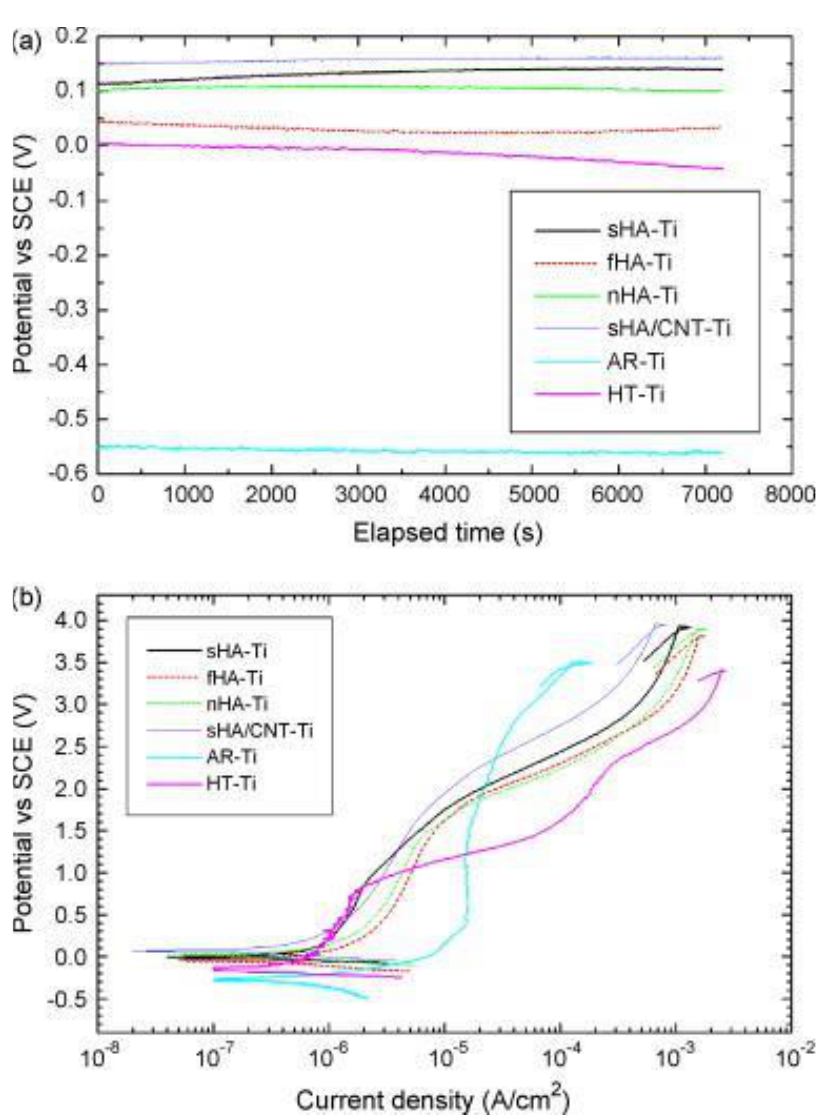
Figure 3. The enhanced corrosion resistance of Ti implants modified with hydroxyapatite (HA) nanoparticles (NPs). ( a ) The open circuit potential (OCP) and ( b ) potentiodynamic polarization curves of non-modified Ti implants and various hydroxyapatite (HA)-coated Ti implants in Hank’s solution. All the HA-coated Ti implants showed significantly higher corrosion potential than the non-coated counterparts (as-received Ti (AR-Ti) and hydrothermal-treated Ti (HT-Ti)). Reproduced with permission from [65].